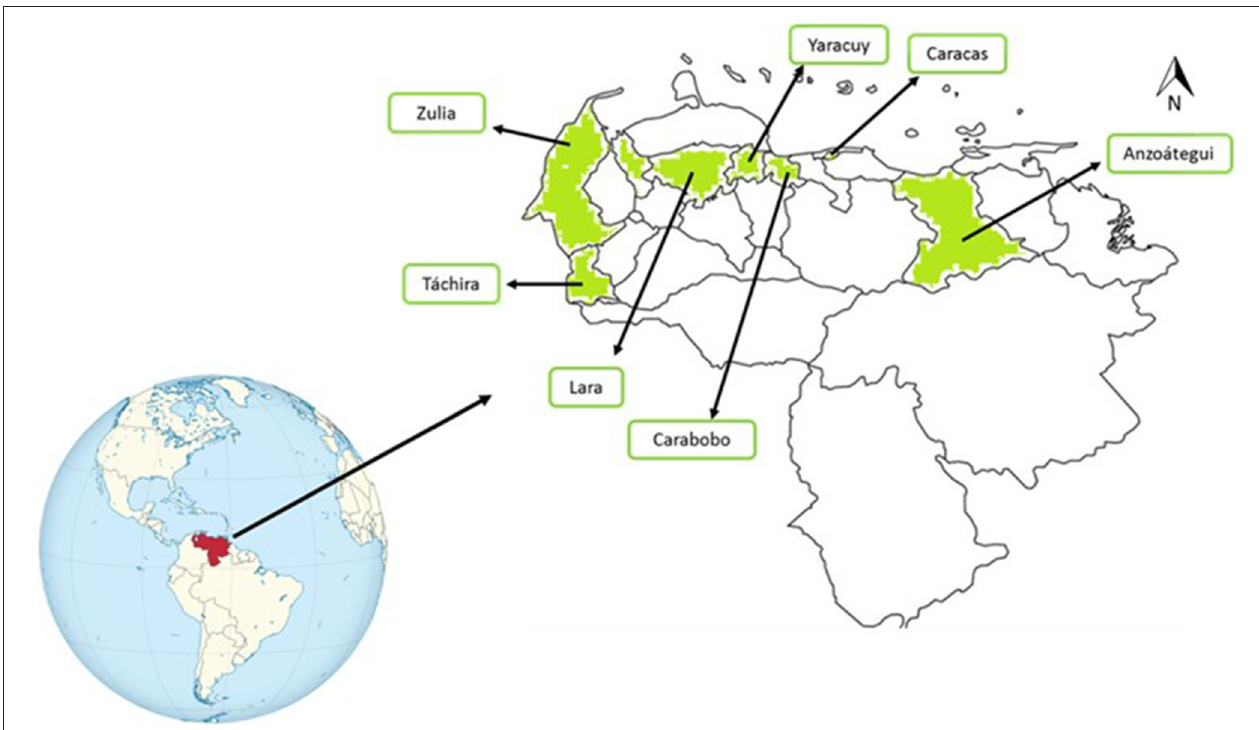
FIGURE 2 | Location of origin migration of families from Venezuela to Colombia.